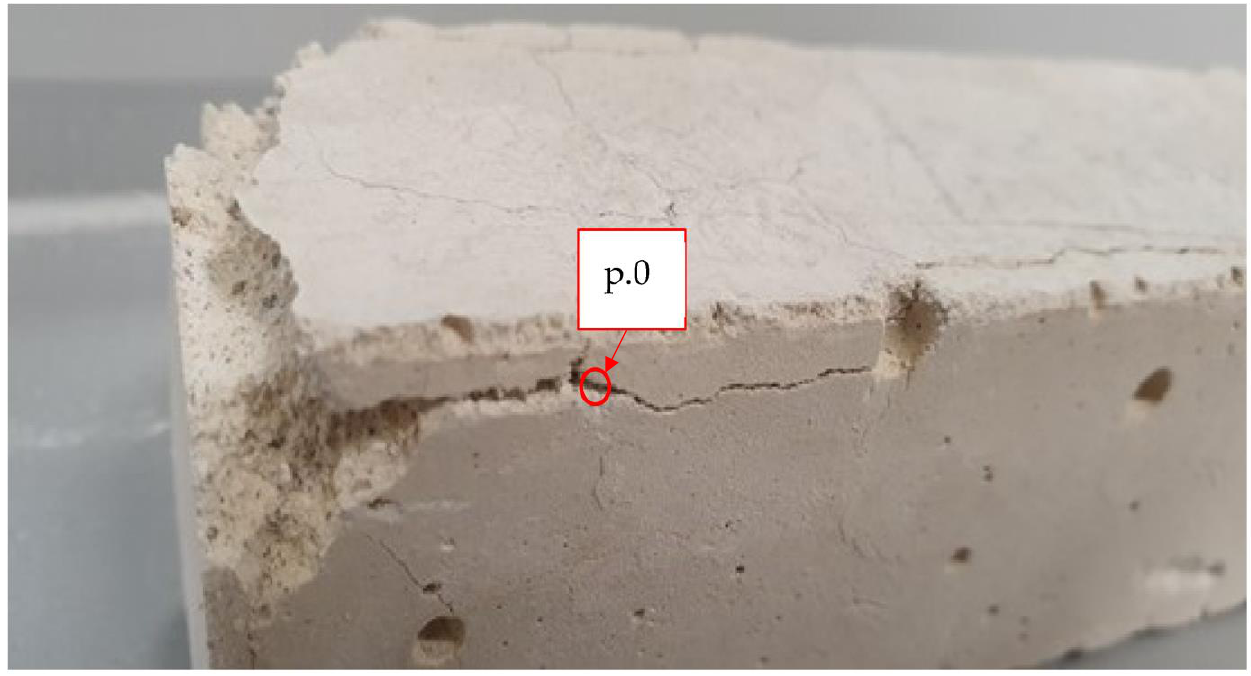
Figure 1. Self-destruction process of lime mortar with 30% fluidised bed ash, F30.